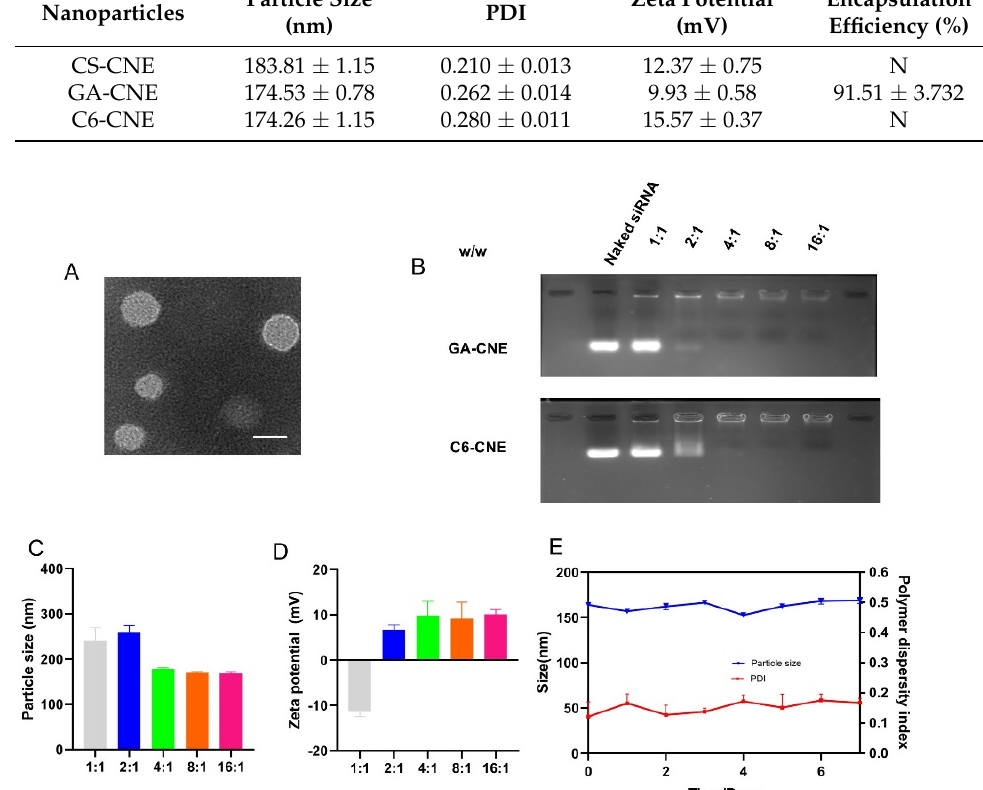
Table 1. Particle Size, Zeta Potential, PDI, and Encapsulation Efficiency of Nanoemulsions (Mean ± SD, n = 3).